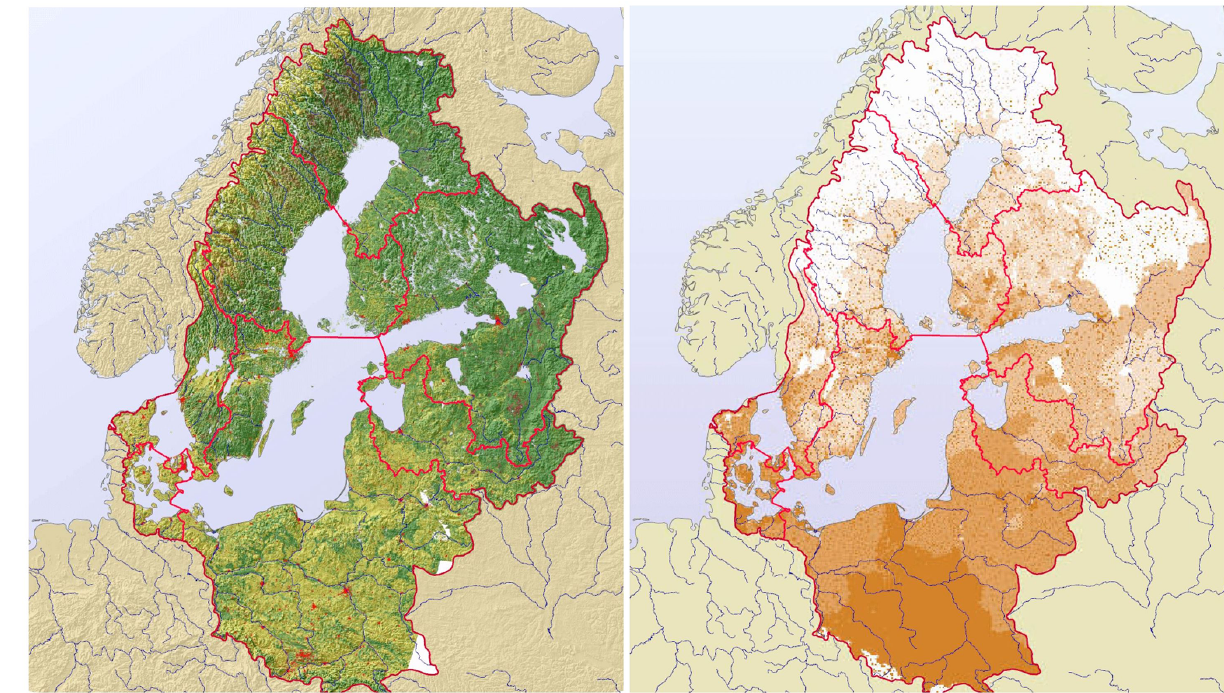
Figure 1. The Baltic Sea drainage basin with land cover (left) and population distribution (right). Dark green: forests; light green: open and agricultural spaces; different shades of orange: population density. Red lines designate drainage sub-basins. Figures are by Hugo Ahlenius, GRID-Arendal Baltic Environmental Atlas, http://www.grida.no (last access: 10 December